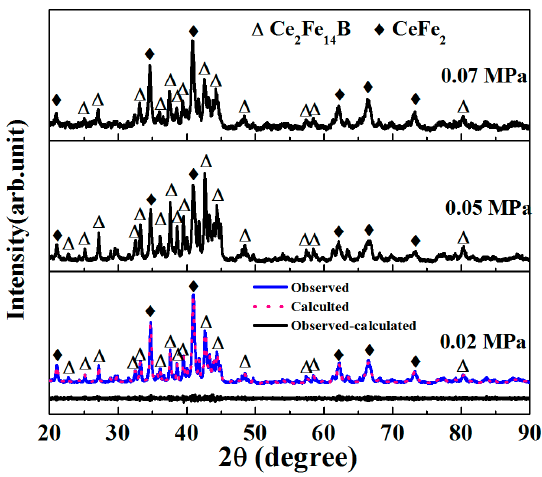
Figure 2 . X-ray diffraction patterns of Ce 17 Fe 78 B 6 ribbons prepared at a constant wheel speed of 15 m·s − 1 , but at chamber pressures of 0.02, 0.05 and 0.07 MPa.